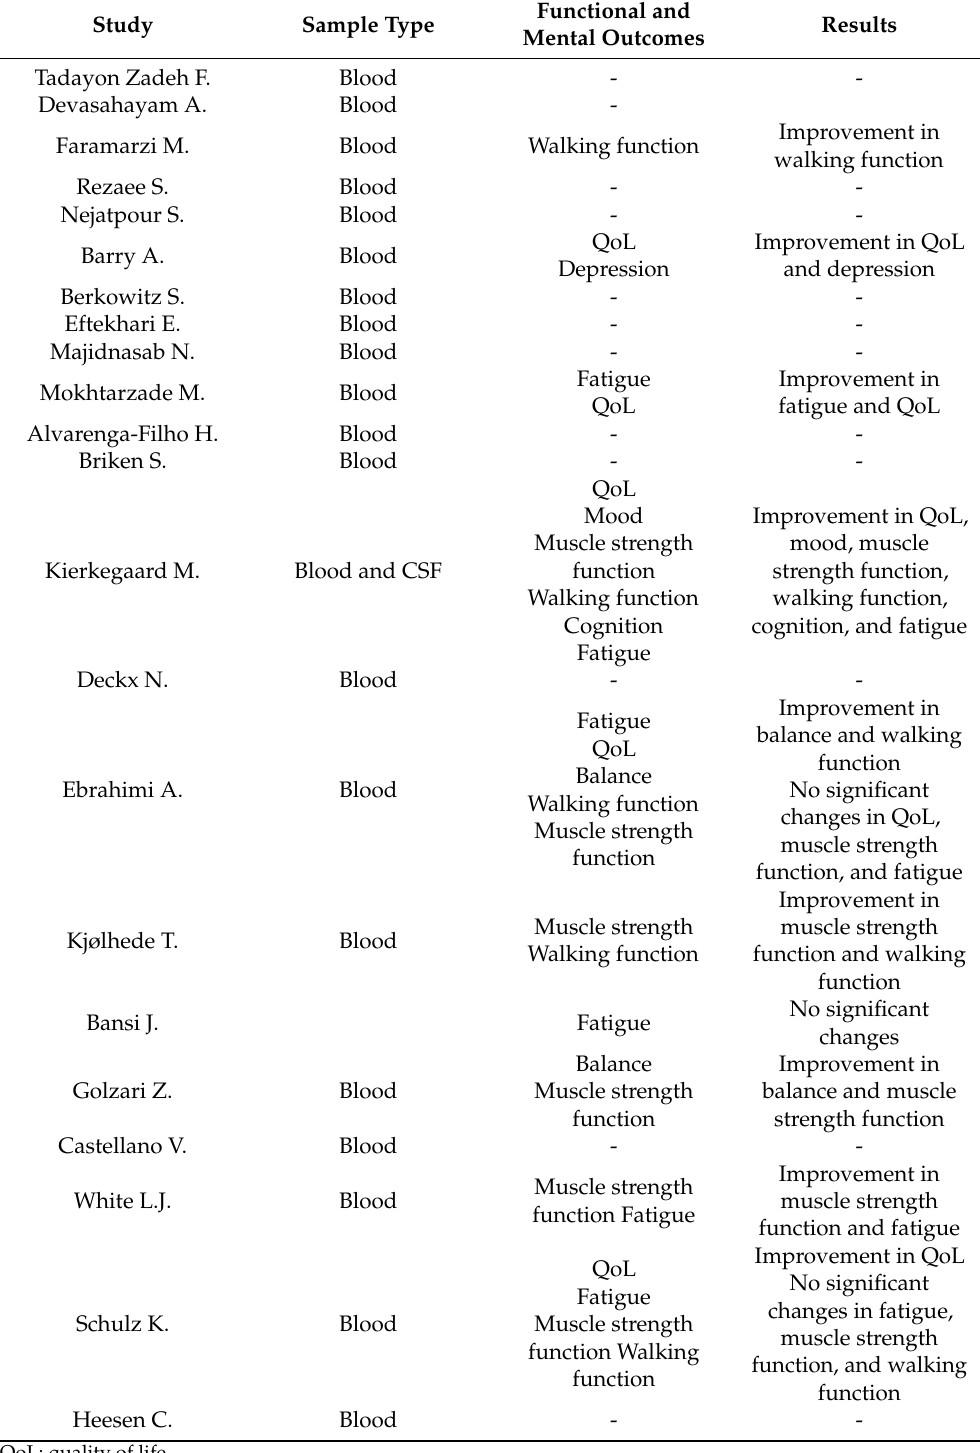
Table 3. The values of physical and mental indices in MS individuals after intervention. Functional and Results Study Sample Type Mental Outcomes Blood - - Blood - Improvement in Blood Walking function walking function Blood - - Blood - - QoL Improvement in QoL Blood Depression and depression Blood - - Blood - - Blood - - Fatigue Improvement in Blood QoL fatigue and QoL Blood - - Blood - - QoL Mood Improvement in QoL, Muscle strength mood, muscle Blood and CSF function strength function, Walking function walking function, Cognition cognition, and fatigue Fatigue Deckx N. Blood - - Improvement in Fatigue balance and walking QoL function Balance Blood No significant Walking function changes in QoL, Muscle strength muscle strength function function, and fatigue Improvement in Muscle strength muscle strength Blood Walking function function and walking function No significant Bansi J. Fatigue changes Balance Improvement in Golzari Z. Blood Muscle strength balance and muscle function strength function Blood - - Improvement in Muscle strength Blood muscle strength function Fatigue function and fatigue Improvement in QoL QoL No significant Fatigue changes in fatigue, Schulz K. Blood Muscle strength muscle strength function Walking function, and walking function function Heesen C. Blood - - QoL: quality of